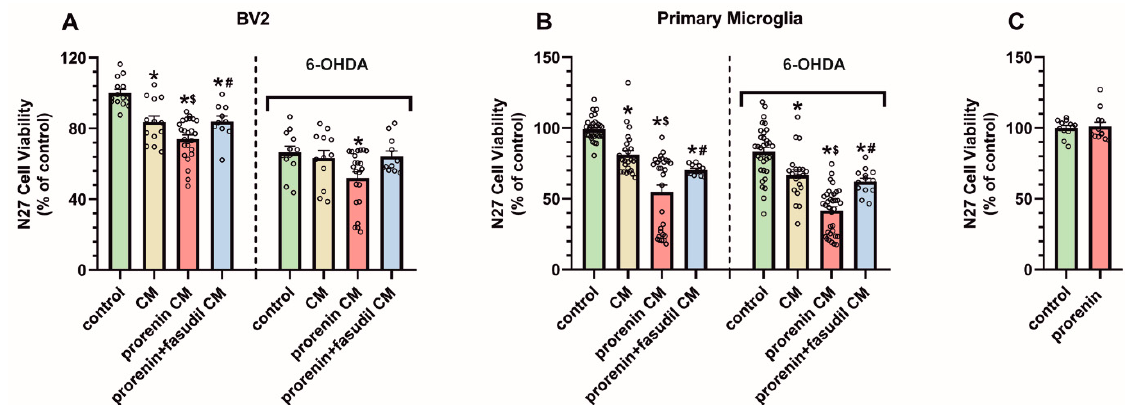
Figure 8. N27 dopaminergic cell viability in cultures, treated or untreated (controls) with low doses of the neurotoxin 6-hydroxydopamine, and conditioned medium (CM) from BV2 ( A ) or primary ( B ) microglial cultures, or CM plus recombi- nant prorenin (5 nM), or CM plus prorenin plus the ROCK inhibitor fasudil (0.2 µ g/ µ L) (in the presence of losartan; 100 nM). N27 cells were also treated with culture medium containing the same doses of prorenin and losartan (in the absence of microglia), and no significant effect on N27 cell viability was observed ( C ). Data were normalized to the values for untreated controls (100%). Data are mean ± SEM. * p < 0.05 relative to the corresponding control, $ p < 0.05 relative to the CM-treated group, # p < 0.05 relative to the CM + prorenin-treated group (One-way ANOVA followed by Holm Sidak post hoc test in A, B; Student’s t ‐ test in C). 6 ‐ OHDA, 6 ‐ hydroxydopamine; CM, conditioned medium.